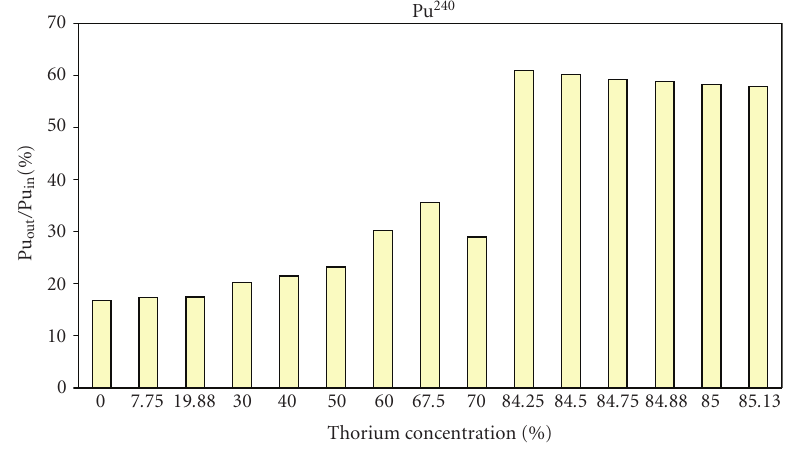
Figure 16: Pu 240 out /Pu 240 in versus Th concentration.